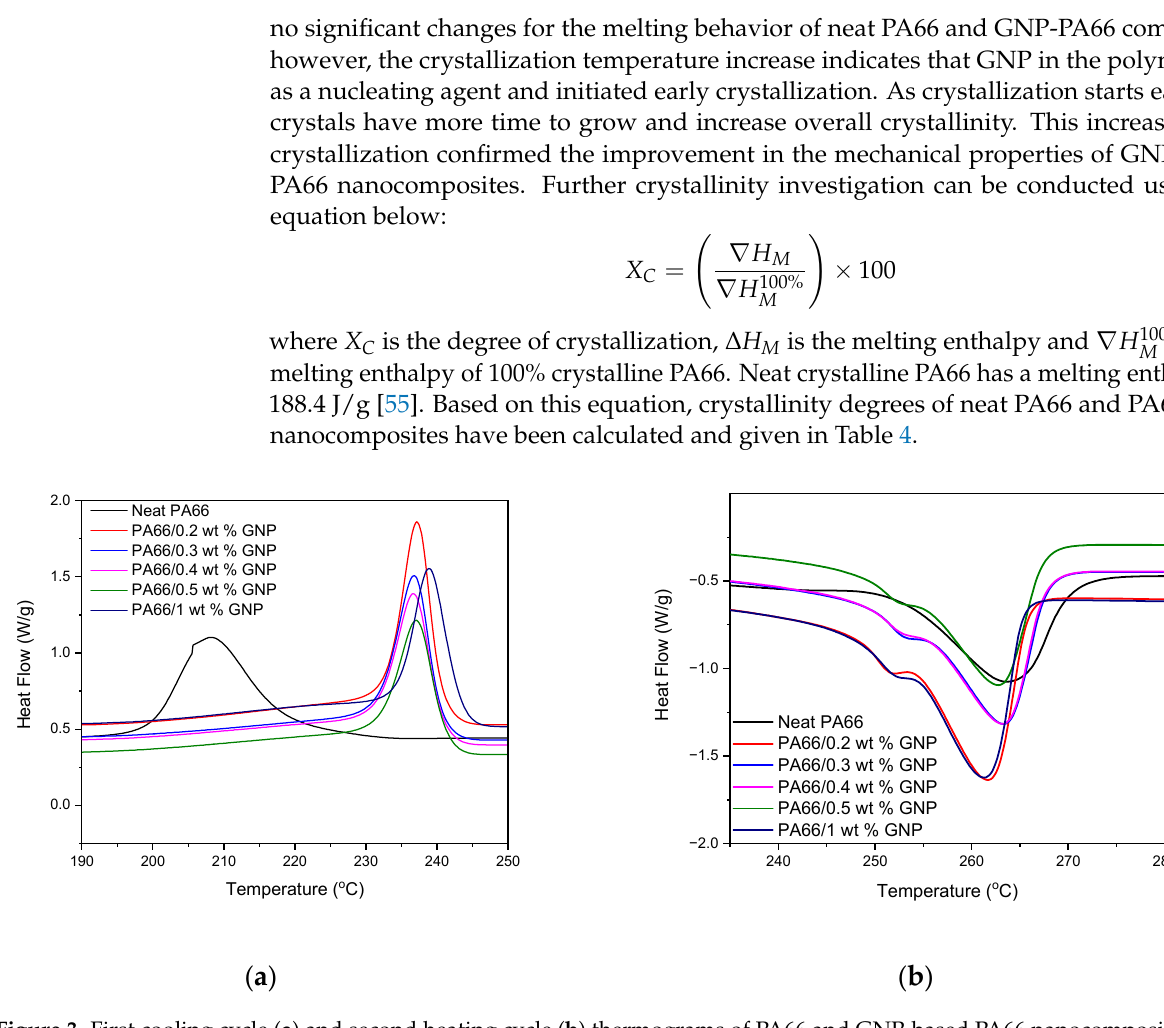
Figure 3. First cooling cycle ( a ) and second heating cycle ( b ) thermograms of PA66 and GNP-based PA66 nanocomposites. Table 3. Melting and crystallization parameters of neat PA66 and PA66/GNP nanocomposites. Sample